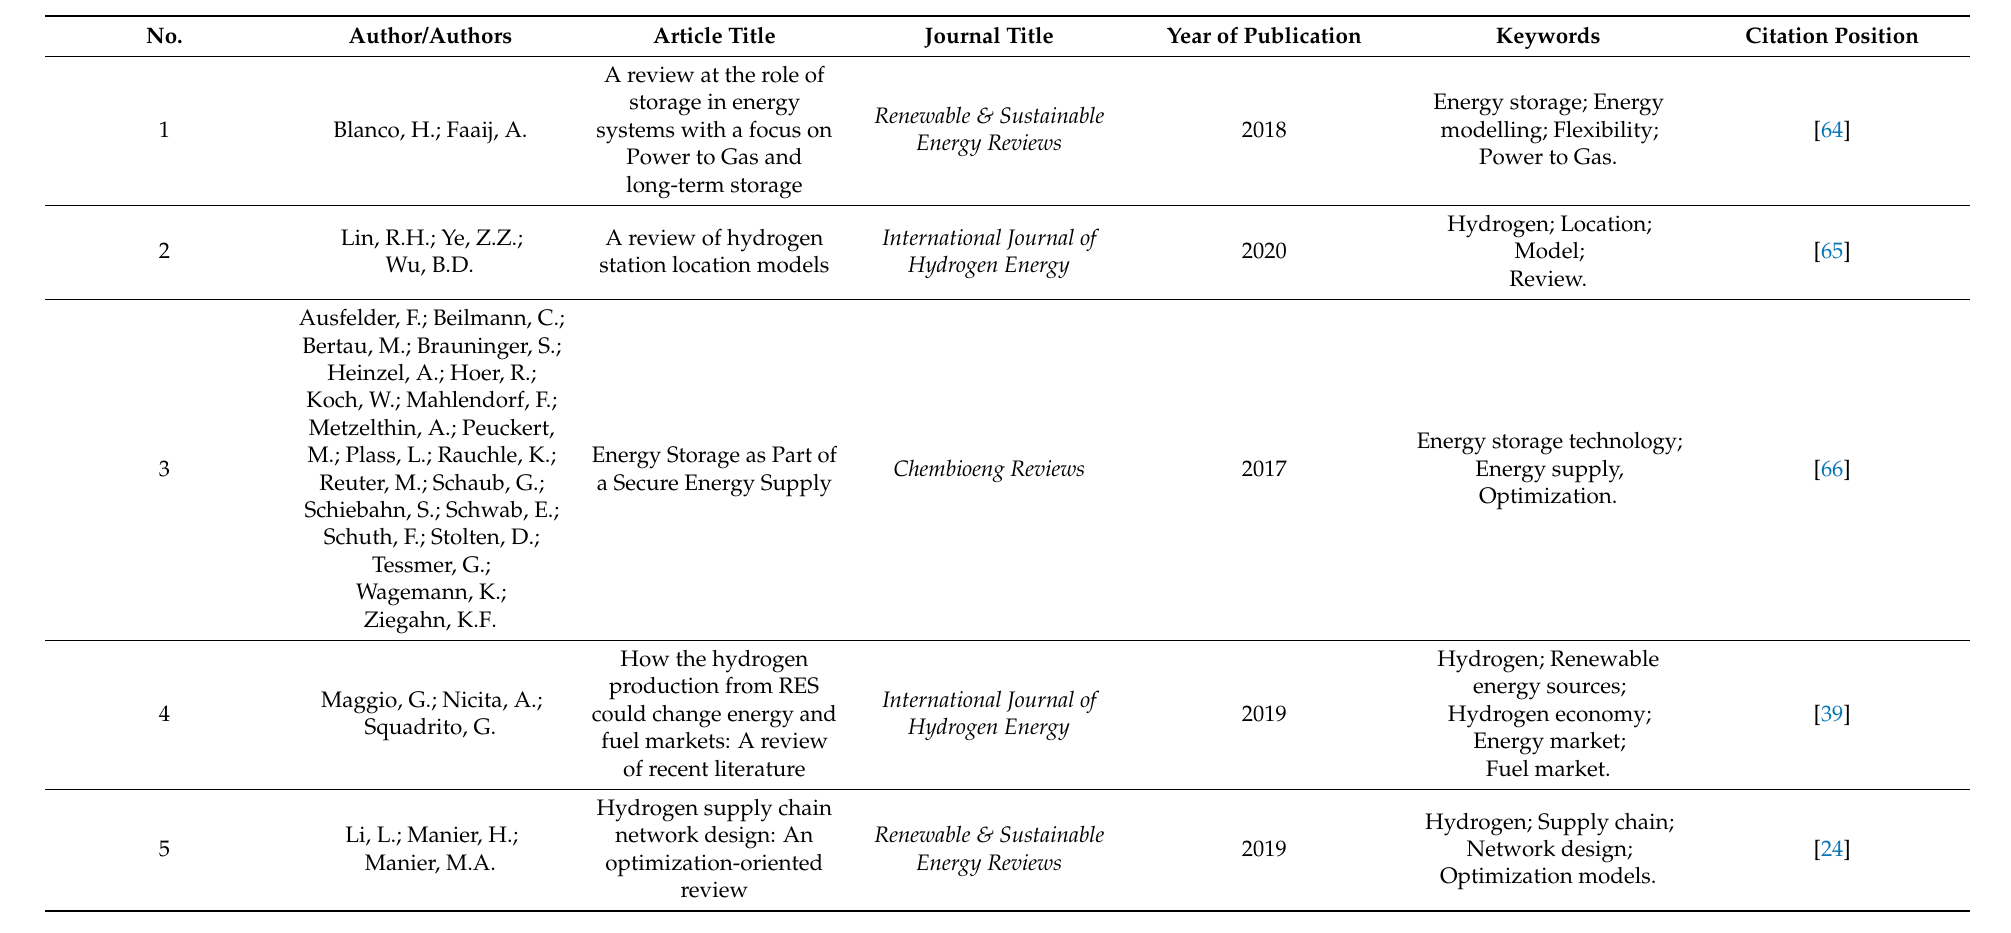
Table A1. List of article titles included in the text